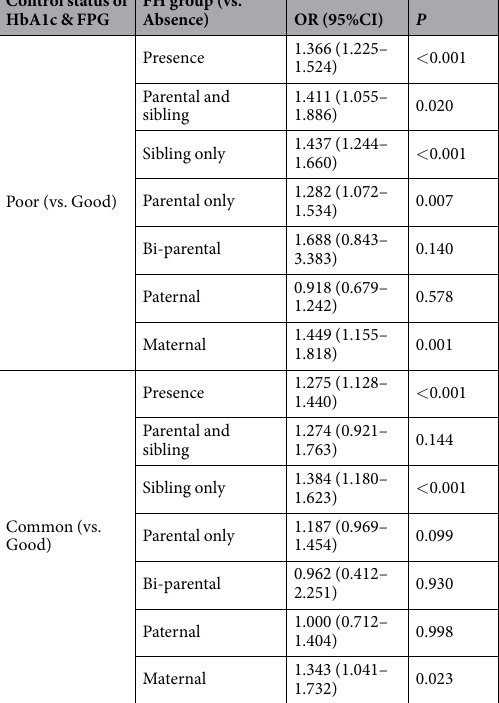
Control status of HbA1c & FPG